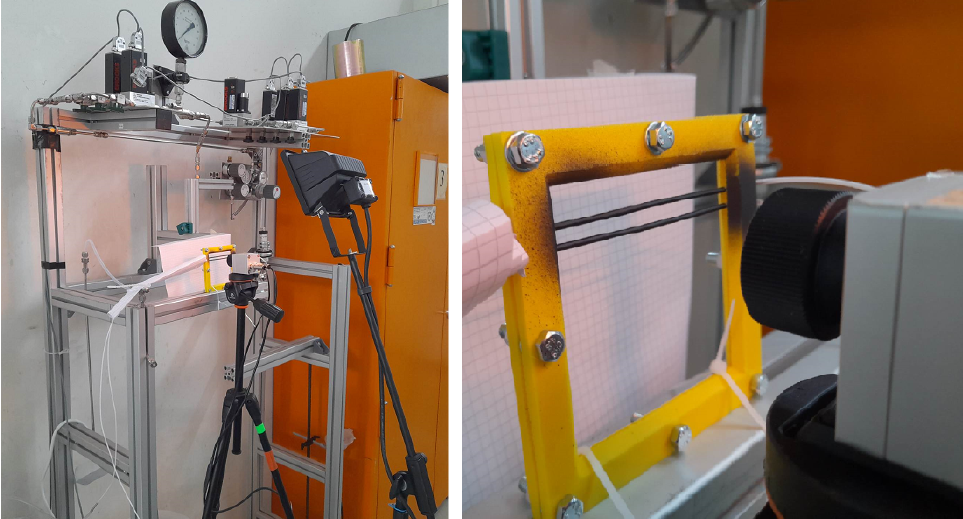
Figure 9. Photos of the experimental measurements; on the left the whole composition of the experiment and on the right a close-up of the